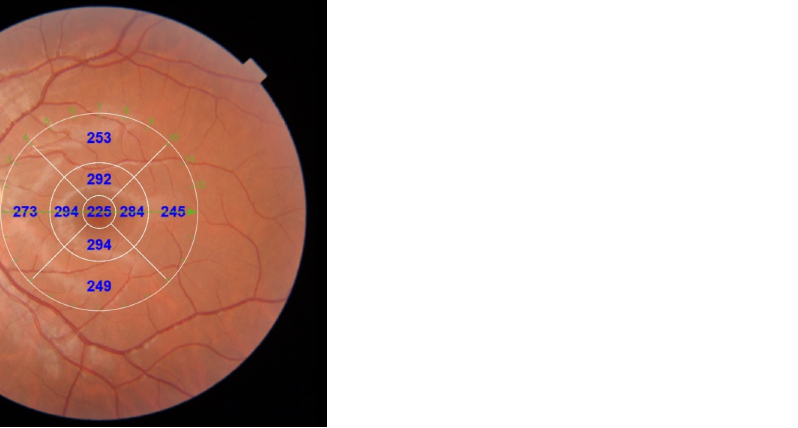
Figure 2. Macular OCT with EDTS grid, which divides the macula into three concentric circles centered on the fovea: the central foveal circle (1 mm), parafoveal circle (3 mm), and perifoveal circle (6 mm). This was divided into the superior, inferior, nasal, and temporal areas.